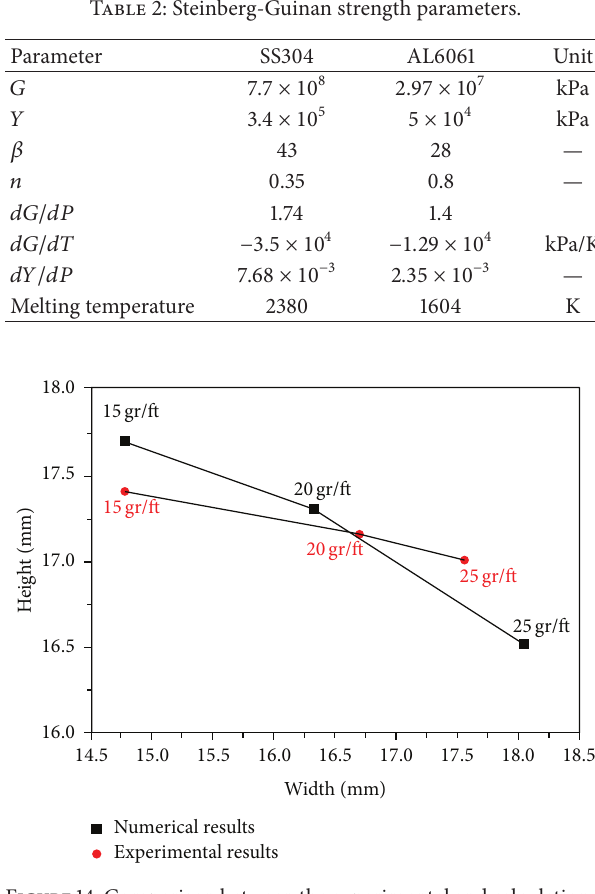
Figure 14: Comparison between the experimental and calculational results.